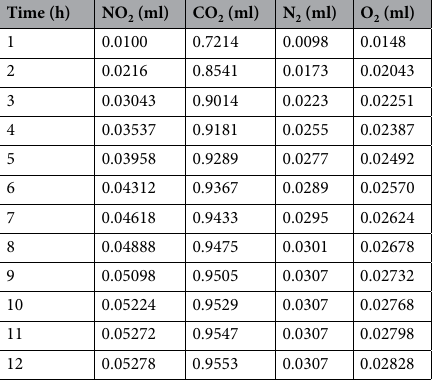
Table 8. Change of accumulated adsorption capacity of 1 g lignite with